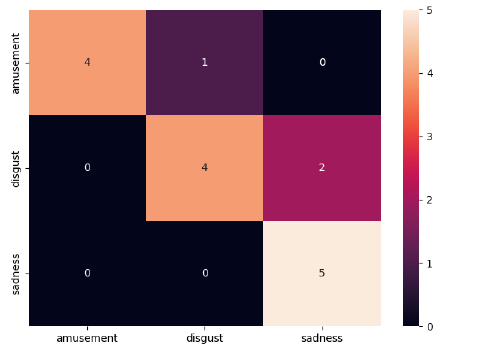
Table 3: Results using the full CWT applied EDA dataset with synthetic data. The parameters are set to: test size = 20 and trees = 100.